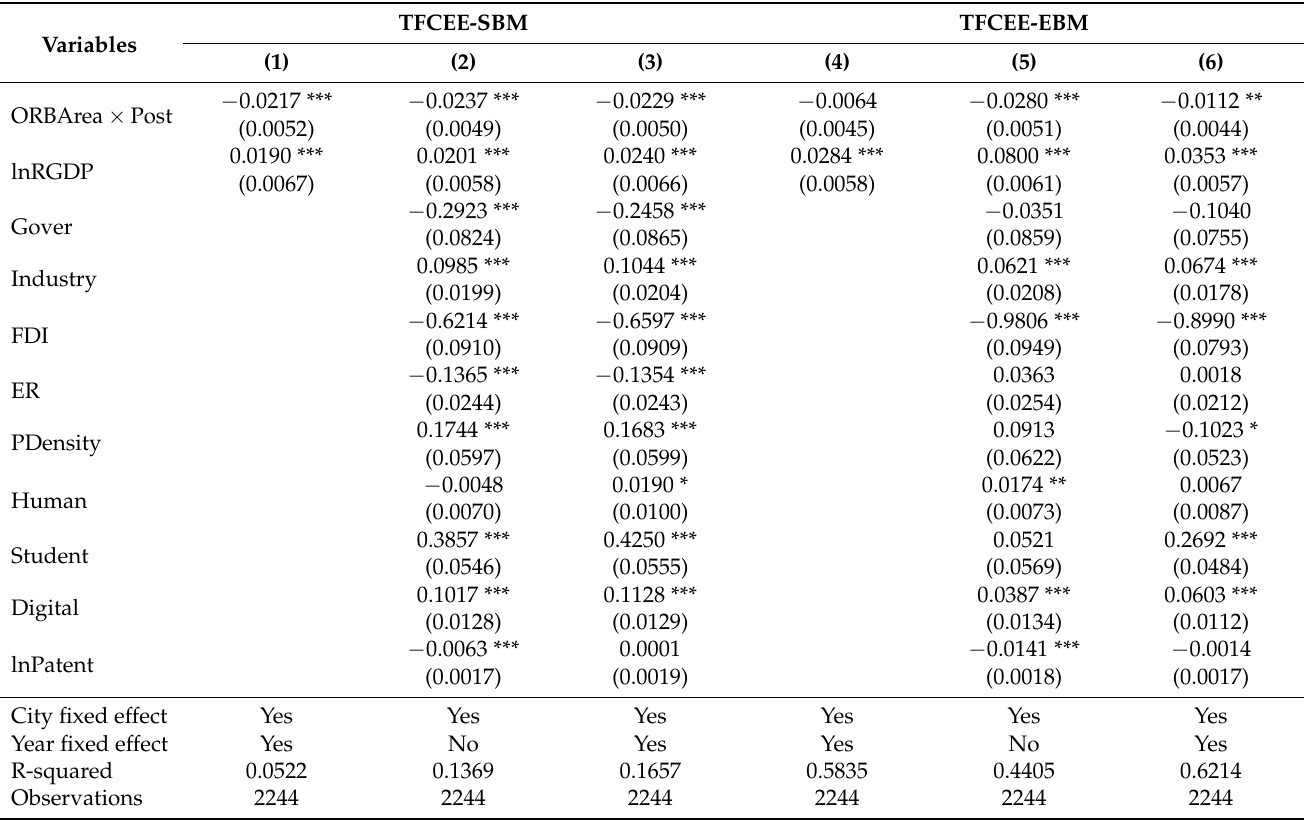
Table 3. Empirical results of DID estimates of policy